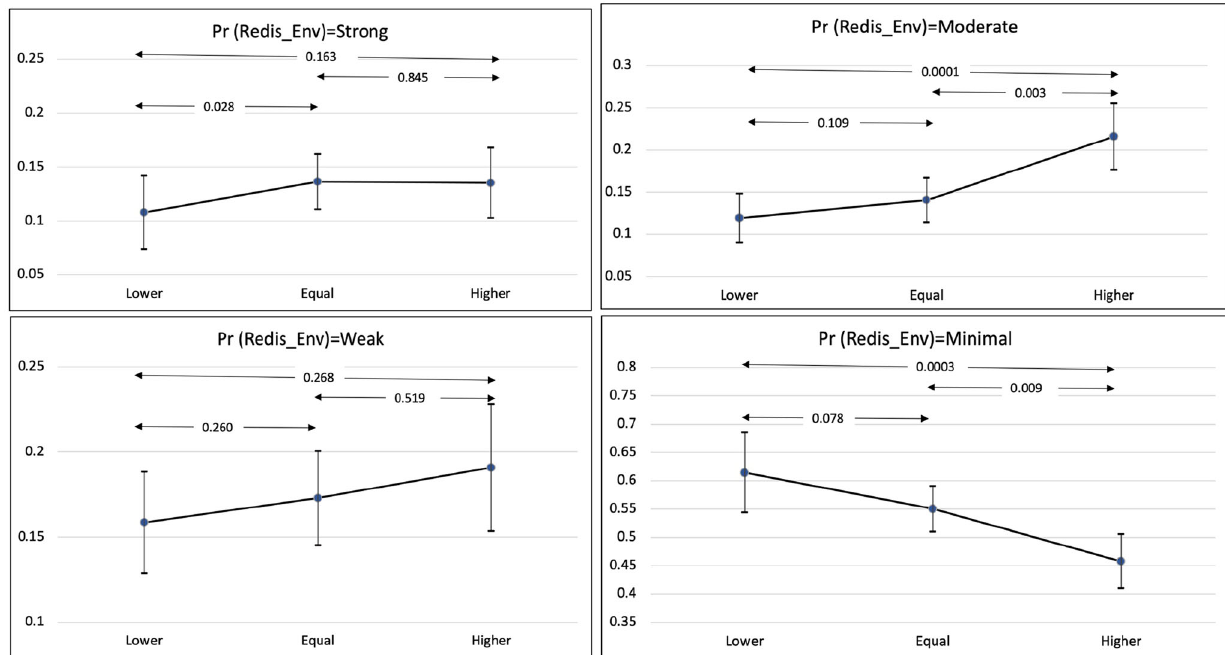
Fig. 1 Effect of inequalities in perceived brute luck on willingness to redistribute in favour of the environment. Each panel represents a level of redistribution (Strong, Moderate, Weak and Minimal). For each luck level (Lower, Equal, Higher), the predictive margin with 95% CIs is presented. For each pair of luck levels, the number corresponds to the p -value of a bilateral equality test computed using delta method.